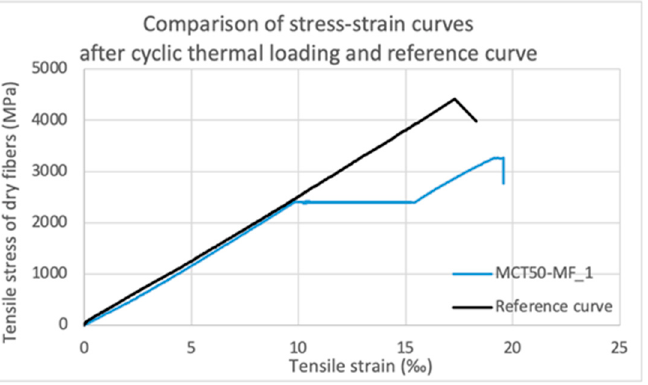
Figure 17. Stress–strain curve of MCT50-MF_1 for low cycle thermal loading under constant tensile load with maximum temperature of the cycles at 50 °C and then a monotonic, uniaxial tensile test. At higher temperatures, heating combined with the continuous loading had an im- portant impact on the CFRPs’ strength as the four samples failed during the first